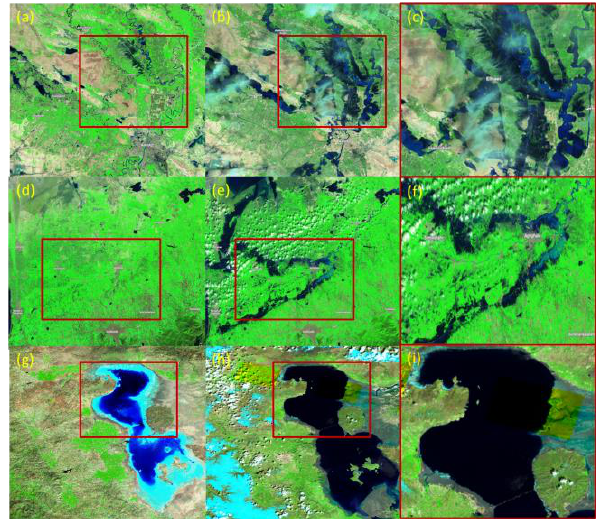
Figure 5. Optical images of the studied regions. From left to right Archive and Crisis images and the zoomed regions with a red border for the study areas. (a-c) Khuzestan, (d-f) Golestan and (g-i) Lake